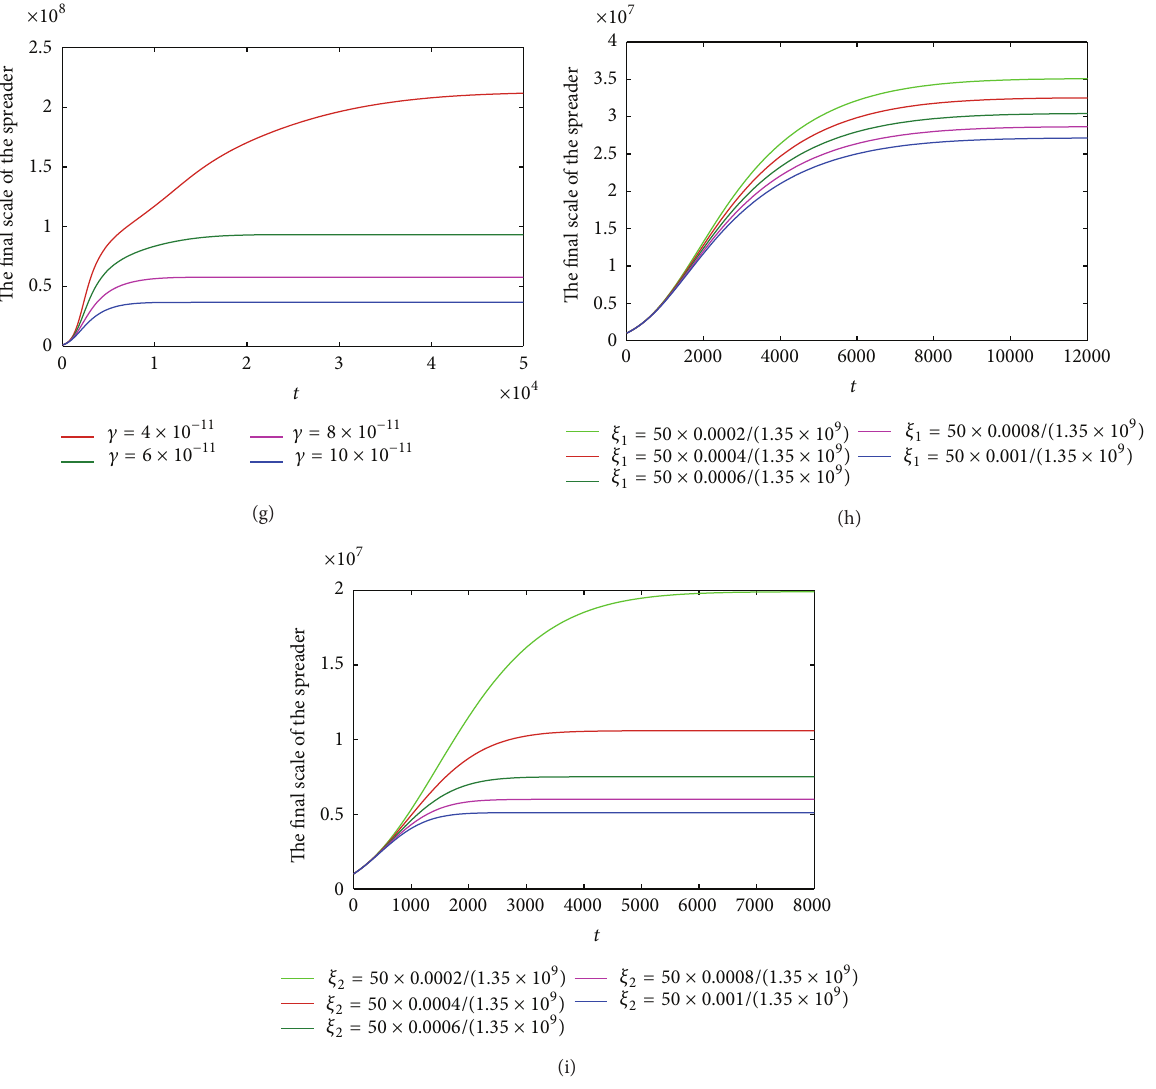
Figure 2: The sensitivity of the final scale in terms of parameters. (a) 𝜃 . (b) 𝜂 . (c) 𝜇 . (d) 𝐵 . (e) 𝛽 . (f) 𝛼 . (g) 𝛾 . (h) 𝜉 1 . (i) 𝜉 2 .